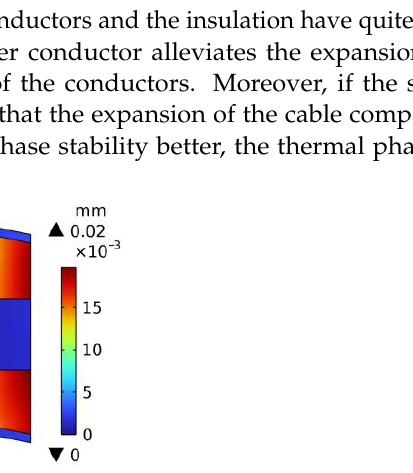
Figure 6. Distribution of the temperature of the cable.